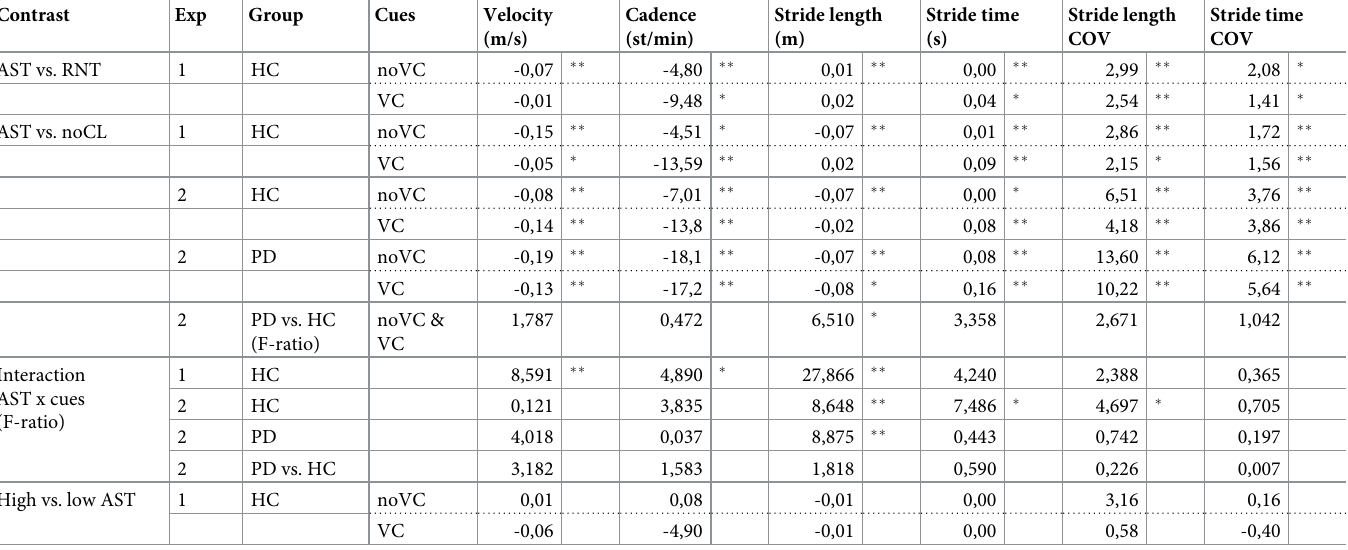
Differences between the median values of conditions, unless stated otherwise. Asterisks indicate statistical significance � p < 0.05 �� p <